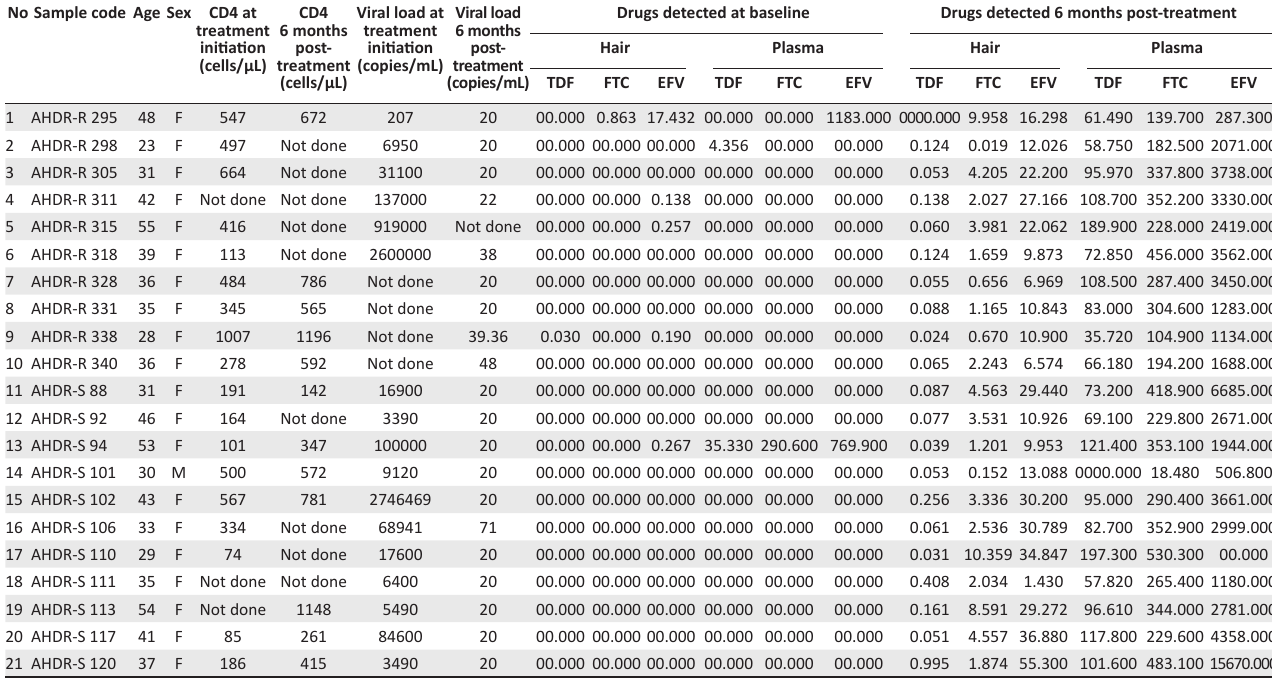
TABLE 5: Study participants’ adherence profiles after 6 months of antiretroviral therapy. No Sample code Age Sex CD4 at